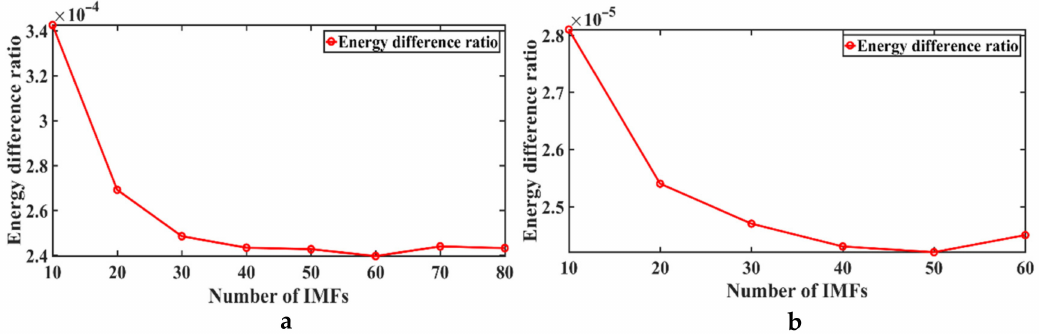
Figure 10. ( a ) Energy difference ratio of the first modal decomposition; ( b ) Energy difference ratio of the second modal